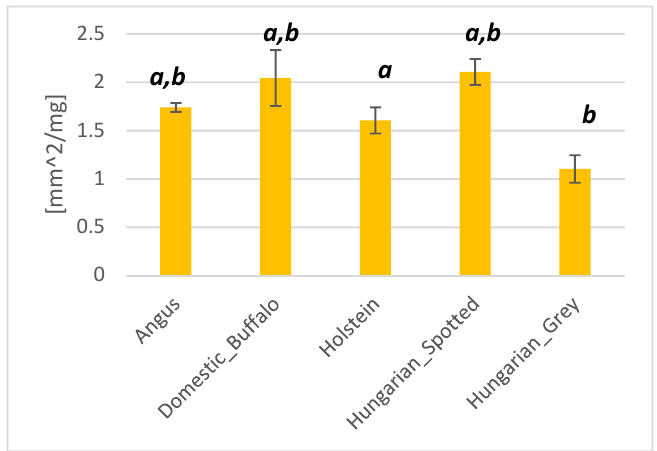
Figure 4. Bar plot showing the water-holding capacity of Angus, domestic buffalo, Holstein, Hun- garian Spotted, and Hungarian Grey bovine breeds. Different superscripts imply significant differ- ences.